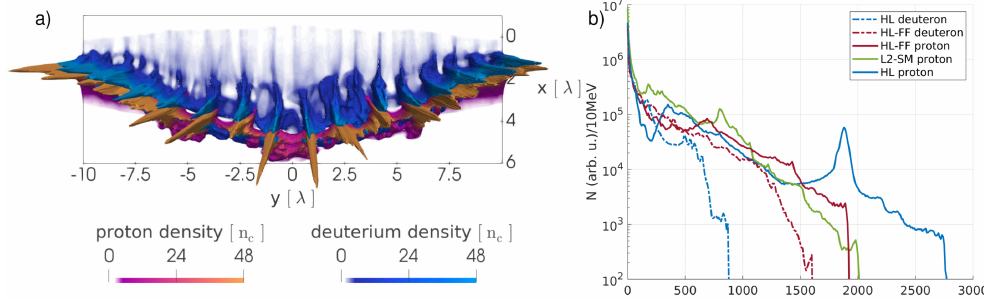
Figure 8. Short-wavelength instability. ( a ) Spatial distributions in the HL-FF (with full-front laser pulse) case at time t = 14 T. Blue and red scales represent deuterium and proton densities, with maximum value set to the initial density. Full density is indicated by the vertical height. ( b ) Proton and deuteron energy spectra for HL (steep-front, interface corrugation), HL-FF (full-front, interface corrugation), and L2-SM (steep-front, surface corrugation) cases at time t = 47 T. Reprinted from [41], with permission from